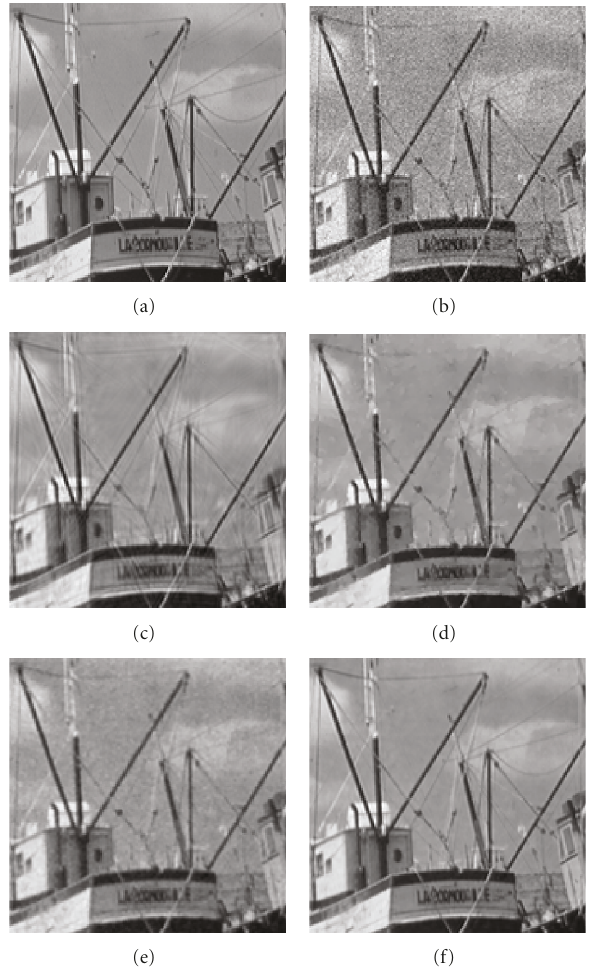
Figure 8: The original, noisy, and restored “Boat” images: (a) the original image; (b) the noisy image (SNR = 7.36, MSSIM = 0.43); (c) the restored image by the curvelet Shrinkage method (SNR = 13.51, MSSIM = 0.76); (d) the restored image by using the “TV” model (SNR = 14.36, MSSIM = 0.78); (e) the restored image by using the “TVGF” model (SNR = 13.25, MSSIM = 0.76); (f) the restored image by using our proposed model (SNR = 14.67, MSSIM = 0.79).